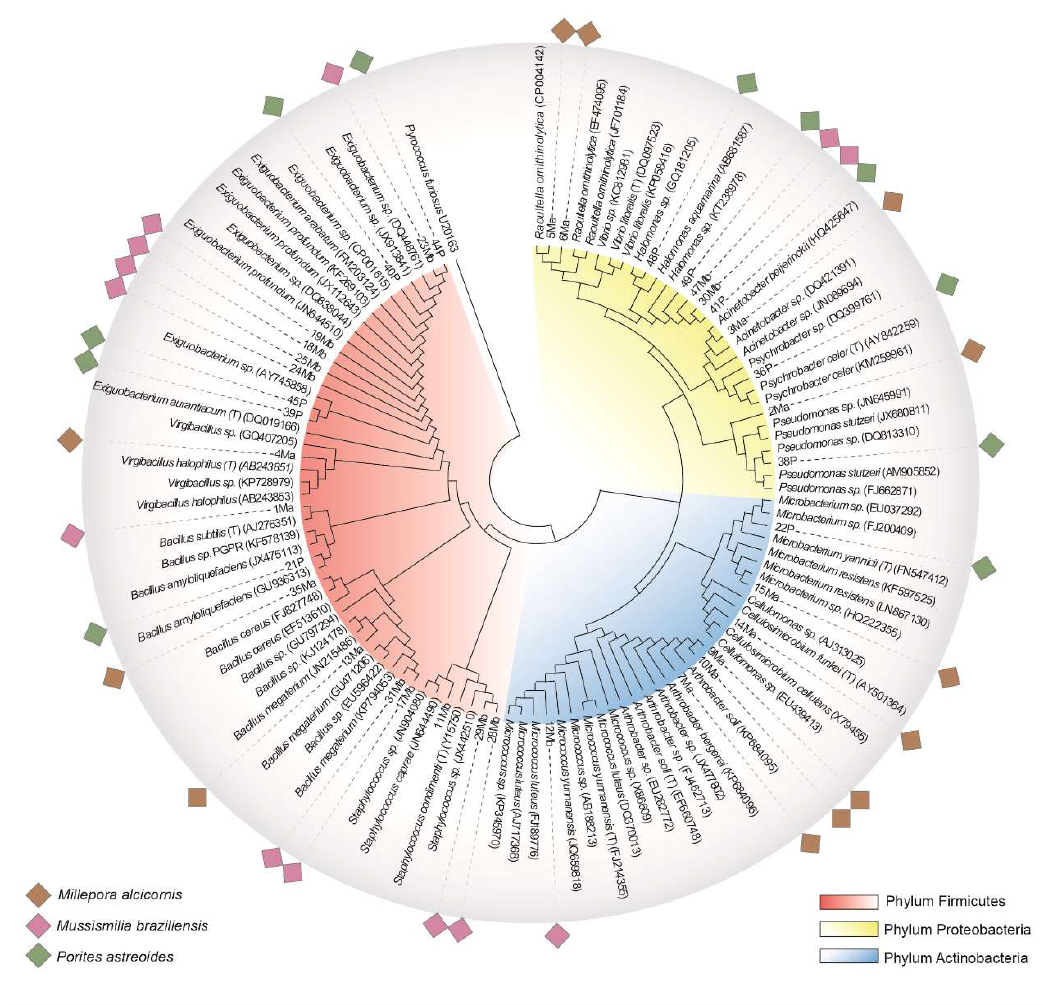
Figure 4. Phylogenetic tree based on the sequences of the rrs (>600 bp) gene, indicating the relationships between 37 isolates and their closest species. The tree was constructed using the MEGA X program based on the Maximum Likelihood method and Tamura–Nei model. Bootstrap analysis with 500 replicates was performed, and the results are shown at branch points. The GenBank accession number of each species is indicated in parentheses. Each color label indicates the coral source of the isolates (brown, M . alcicornis; pink, M . braziliensis ; and green, P . astreoides ). Each branch color indicates the phylum of the isolates (red, Firmicutes; blue, Actinobacteria; and yellow, Proteobacteria).